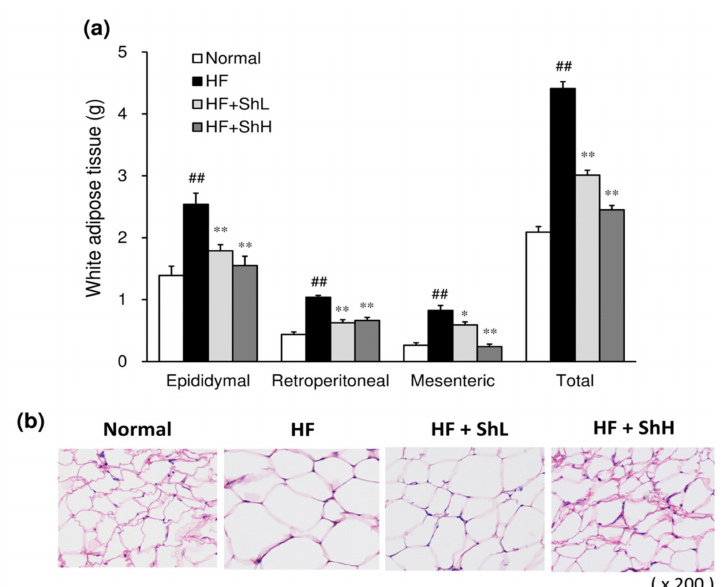
Figure 2. Effects of S. horneri on the mass and morphology of white adipose tissue in C57BL/6J mice fed a high-fat diet for 13 weeks. After the mice were sacrificed, masses of epididymal, retroperitoneal, and mesenteric white adipose tissue were determined ( a ). Adipose tissue was fixed, and the section of epididymal adipose tissue was stained with hematoxylin and eosin (HE) ( b ). Normal, normal diet; HF, high-fat diet; HF + ShL, high-fat diet mixed with 2% S. horneri ; and HF + ShH, high-fat diet mixed with 6% S. horneri . Each value represents the mean ± SEM ( n = 8). Significant difference: * p < 0.05, ** p < 0.01 vs. HF group, ## p < 0.01 vs. Normal